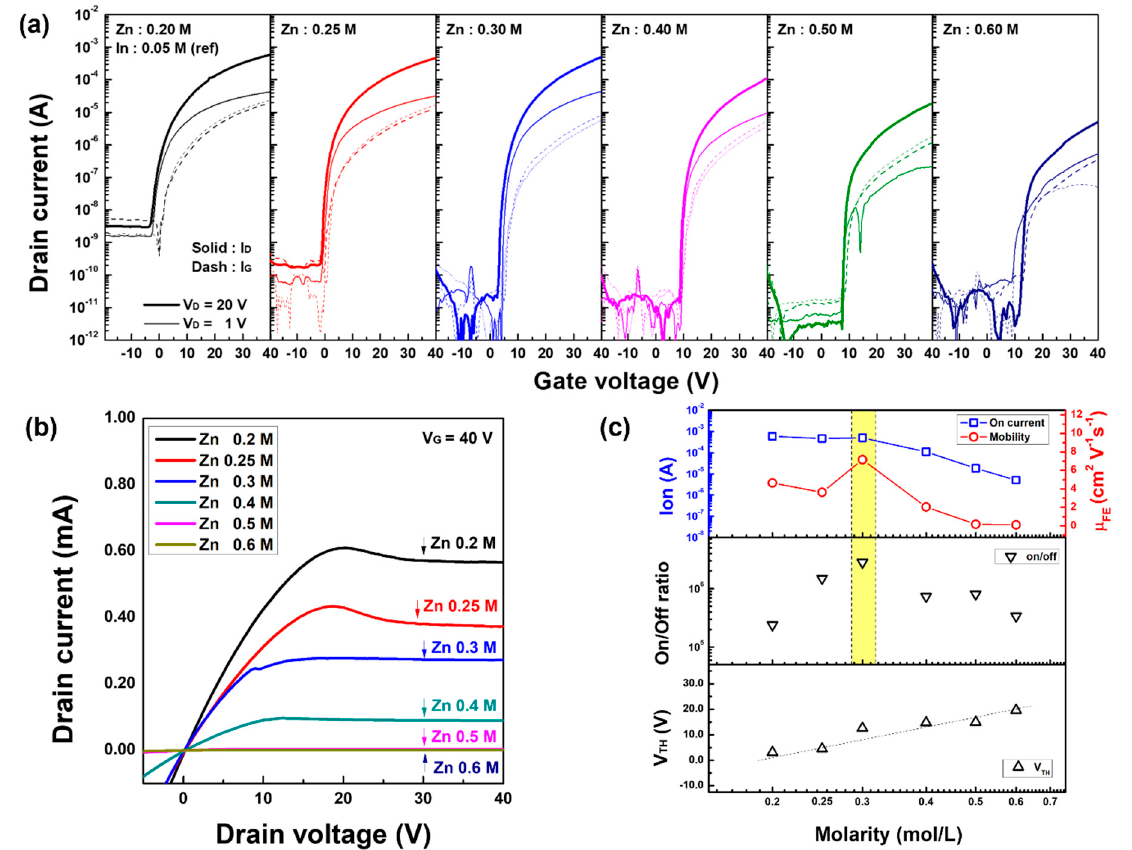
Figure 7. Electrical characteristics of solution-processed a -IZO TFT with respect to the Zn molarity. ( a ) Transfer curves, ( b ) output currents, and ( c ) electrical parameters of the TFT. In ( a ), the thick/thin lines represent saturation/linear conditions and solid/dashed lines indicate I D /I G , respectively.